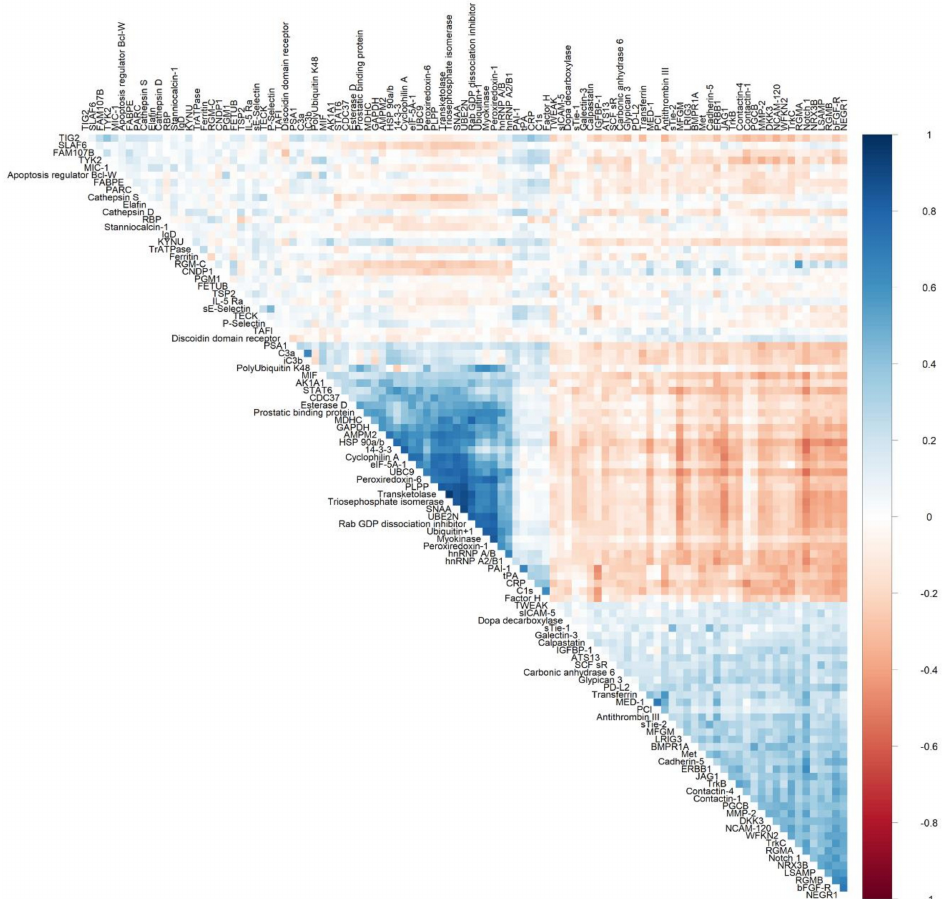
Figure 3. Heatmap depicting Spearman’s partial correlation coe ffi cients adjusted for age and sex between proteins that were statistically significant (FDR p ≤ 0.05) in multivariable models adjusting for age, sex, total caloric intake, current smoking, physical activity index, lipid lowering medication, anti-hypertensive medication, and body mass